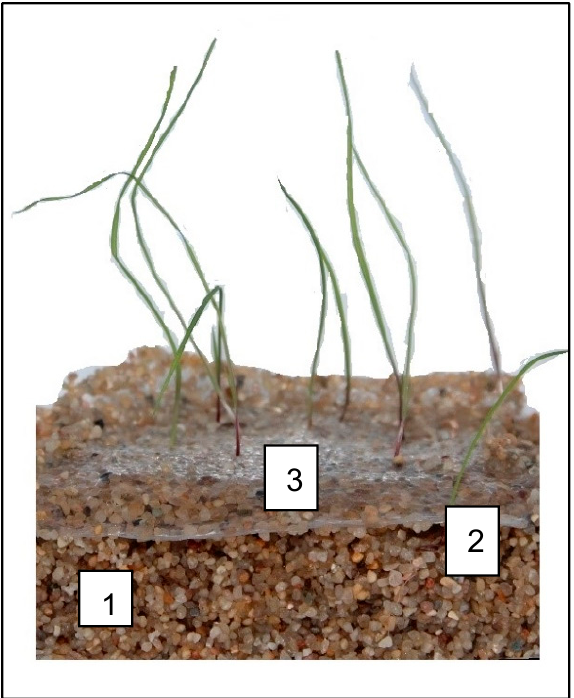
Figure 4. Structure of the agar test: 1st layer = fire-dried quartz sand; 2nd layer = pre-germinated A. myosuroides seeds; 3rd. layer = agar plate consisting of agar, herbicide and nutrients. Plants showed in the picture are from the sensitive standard treated with no herbicide, 7 days after